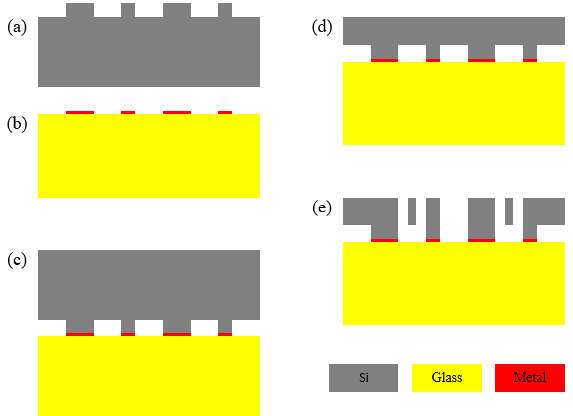
Figure 4. The sample ( a ) and structural diagram of sensor ( b ).